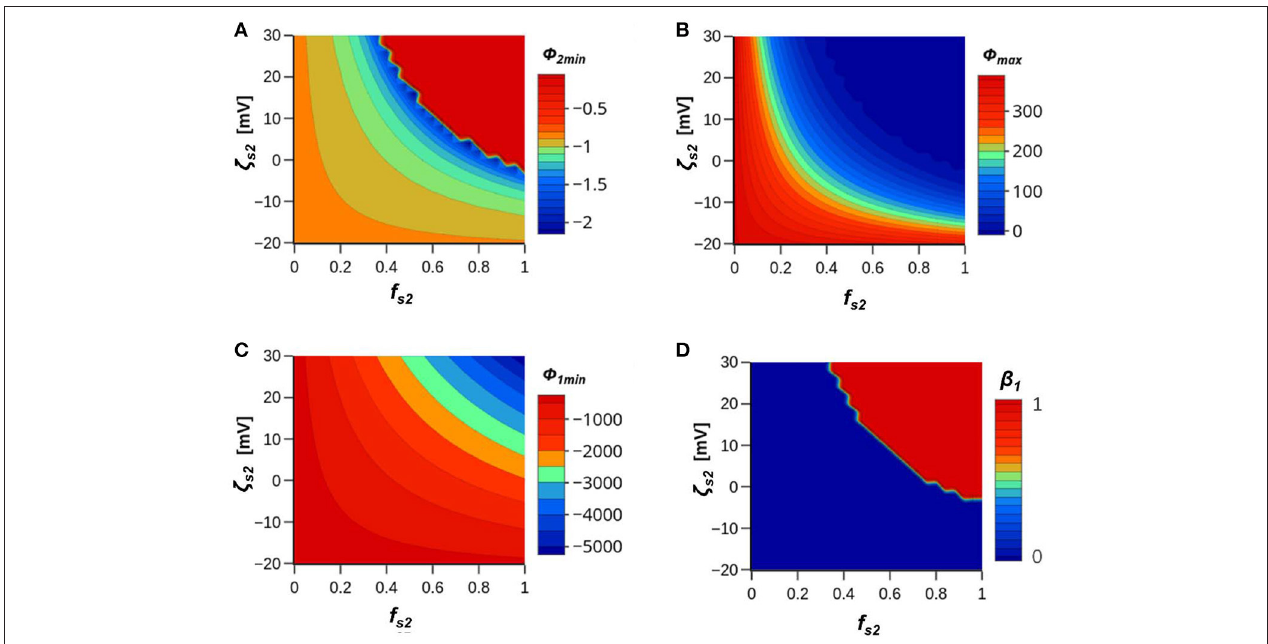
FIGURE 3 | Contour plots of (A) Φ 2min , (B) Φ max , (C) Φ 1min , and (D) β 1 for a hydrophilic bacterium when the IS double layer interaction on the solid phase was considered. The solid phase zeta potential and fraction on site 2 were varied from ζ s 2 and values of ζ s 1 and ζ c 1 were equal to